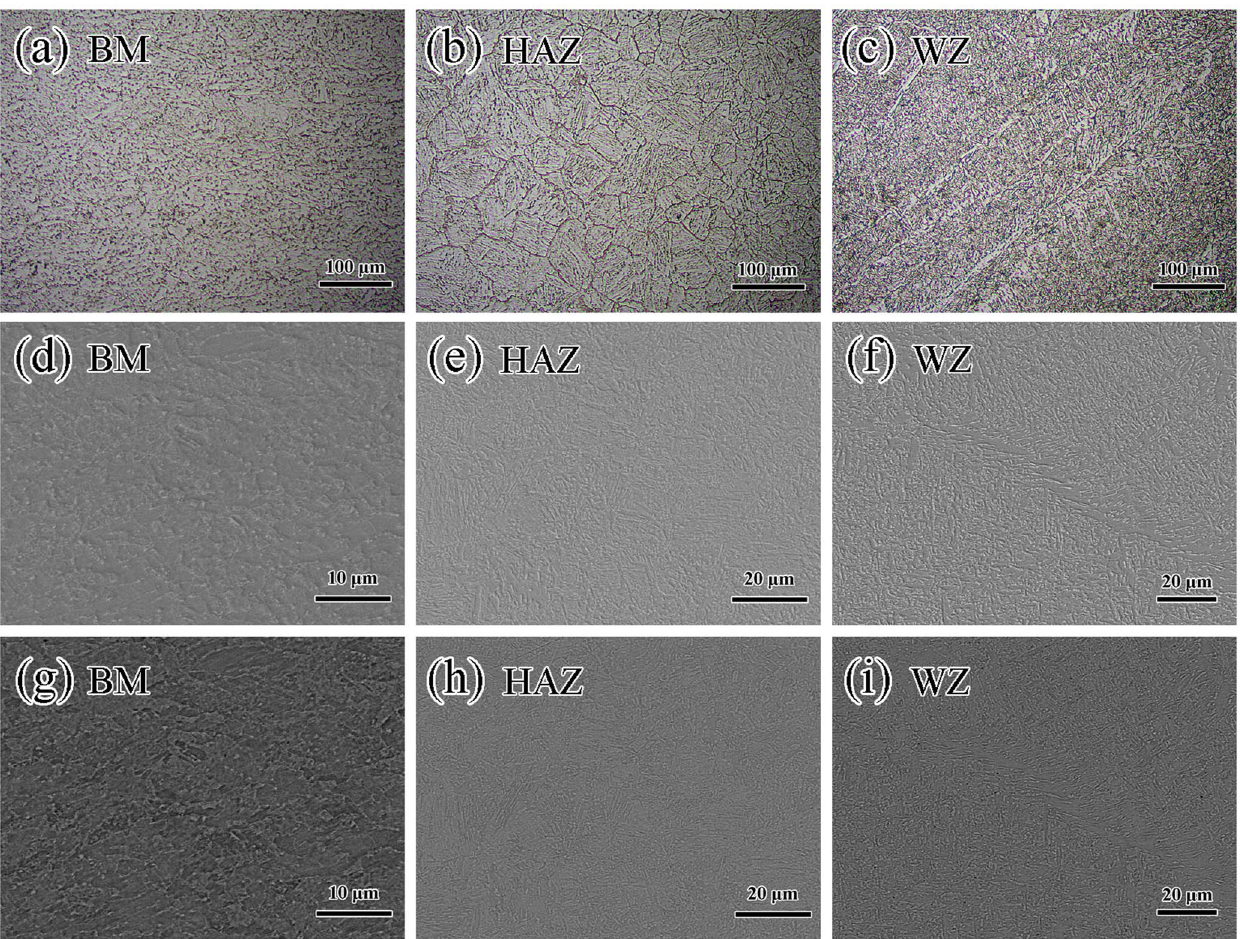
Fig. 11 Microstructures of welded joints. a – c Show the metallographic photos of the welded joints. d – f Show the secondary electron images of the welded joints. g – i Show the backscattered electron images of the welded joints.